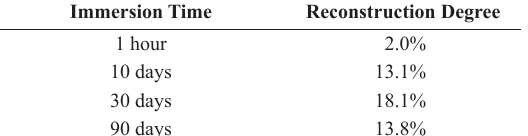
Table 1. Reconstruction degree of oxide film on Ti6Al4V after immersion tests in artificial blood solution at room temperature. Immersion